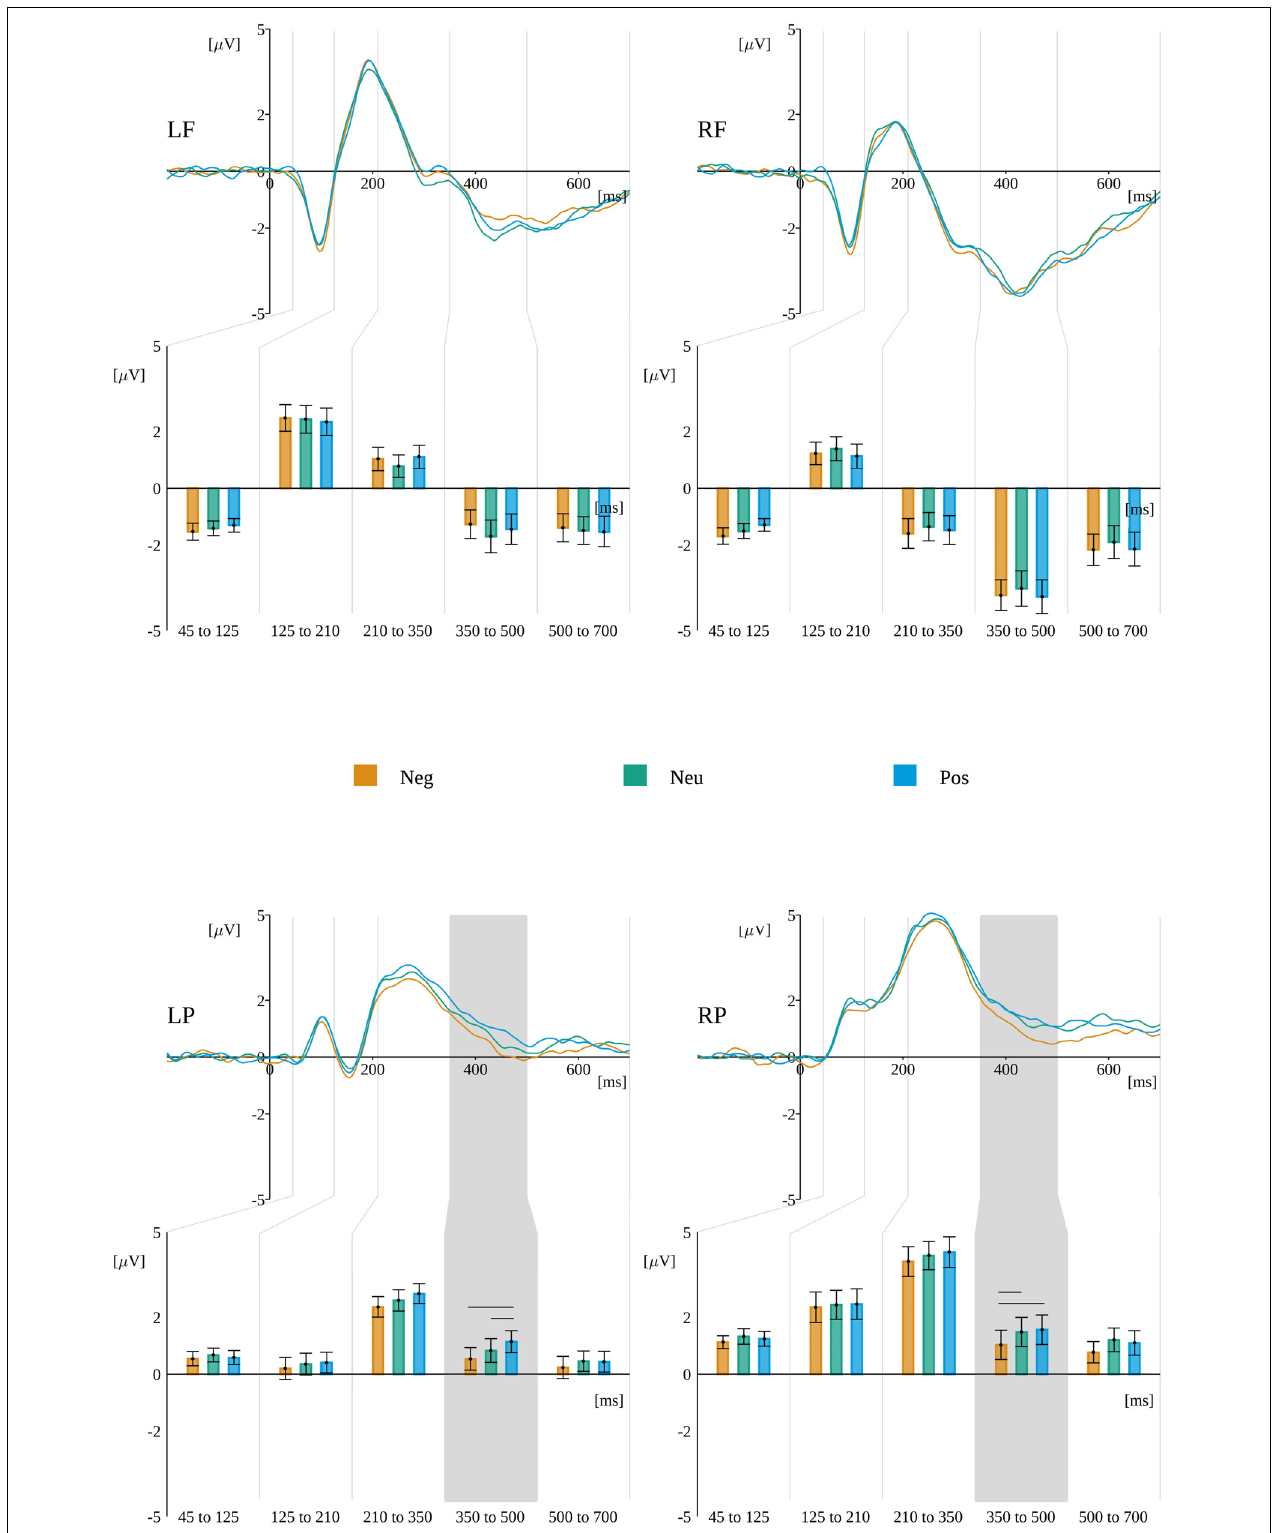
FIGURE 7 | Effects of valence in subsequent time windows during word reading in different ROIs. For each ROI the time course of ERP for each level of valence is plotted. Gray backgrounds mark time windows with statistically significant valence–ROI interactions. Beneath, the bars present the amplitude averaged within each time window. Horizontal lines indicate levels of valence that differ